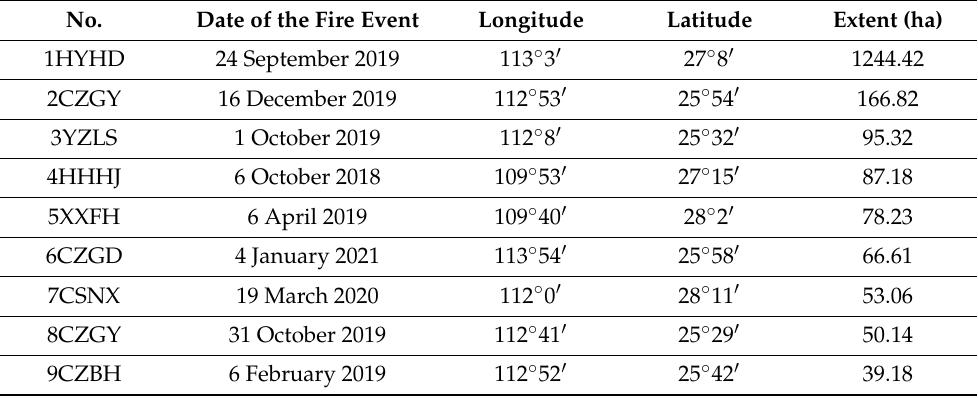
Figure 3. Field measurement confirmation and reports in details by well-trained personnel. Panels ( A , B ) show the fire scar sites. Panel ( B ) show that the trained personnel were using UAV (the UAV is shown in red circle) and other equipment for field surveys. Panel ( C ) shows the manually created vector data of burned area. Table 3. Fire information at the fifteen selected